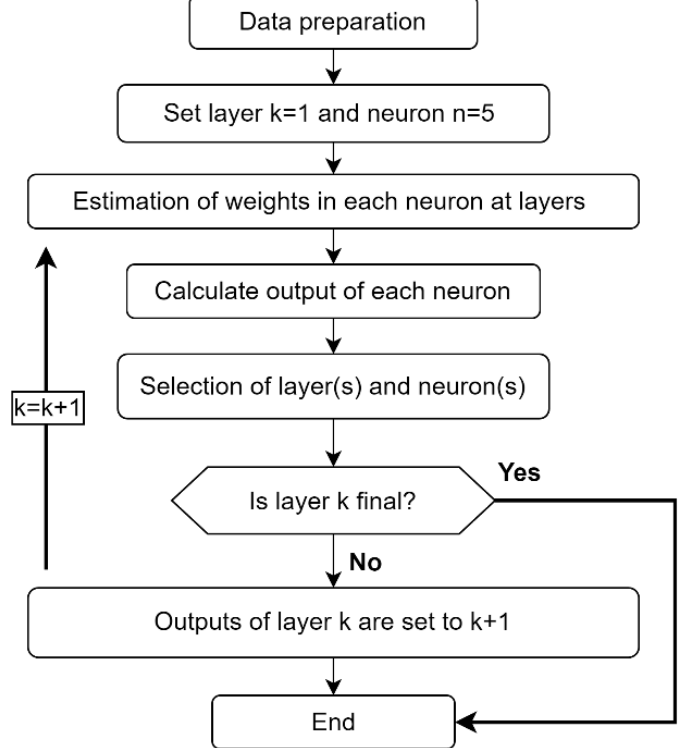
Figure 4. Flowchart of the proposed GMDH-type NN approach.